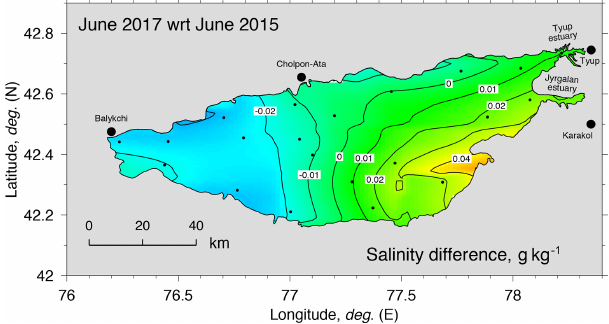
Figure 6. Difference of salinities at the surface observed in June 2017 and June 2015, based on data from hydrographic stations indicated by bullets.